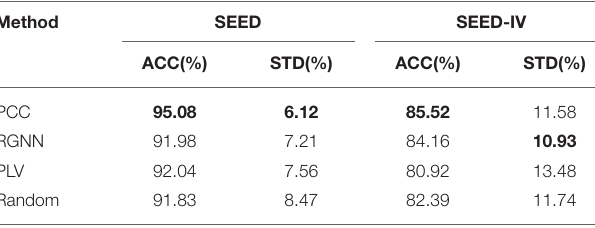
TABLE 4 | The SEED data set and SEED-IV data set are compared by using different adjacency matrix A initialization methods. Method